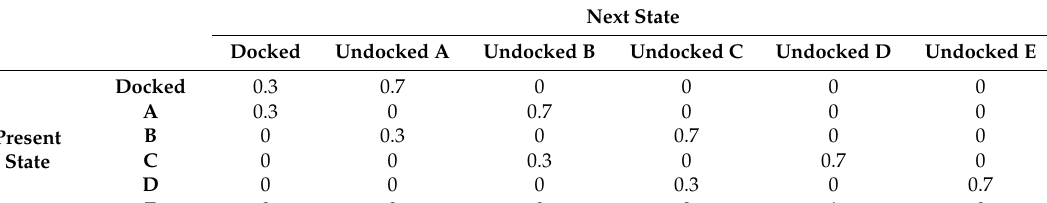
Table 9. State transition table of the emulated walk that follows Markov process—Activity level: High. Next State